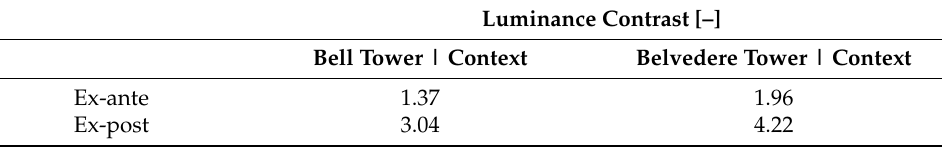
Table 16. Observation point E1. Luminance